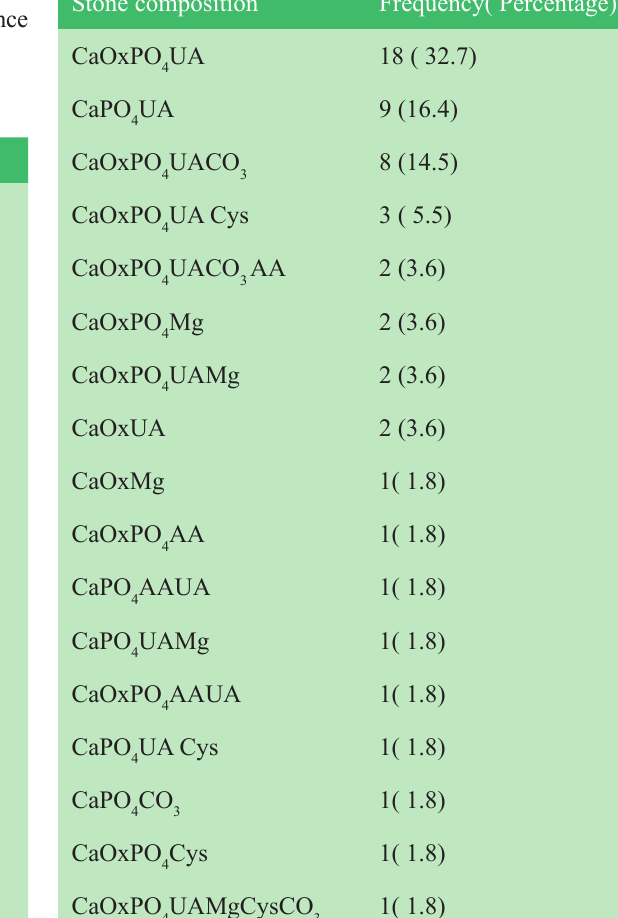
Table 3 Stone composition Stone